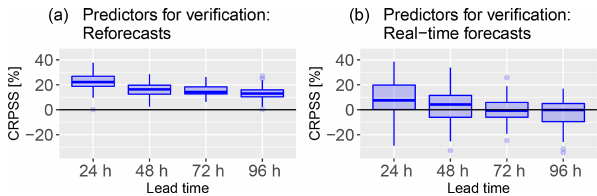
Figure 10. CRPS of HN (cm) as a function of prediction lead time for post-processed forecasts from local-scale calibration with the reforecast dataset (1994–2016) and applied during winter 2015– 2016. (a) Predictors for the verification are taken from the refore- cast; (b) predictors for the verification are taken from the real-time forecasts. The boxplot represents the variability of scores between the 47 stations in the French